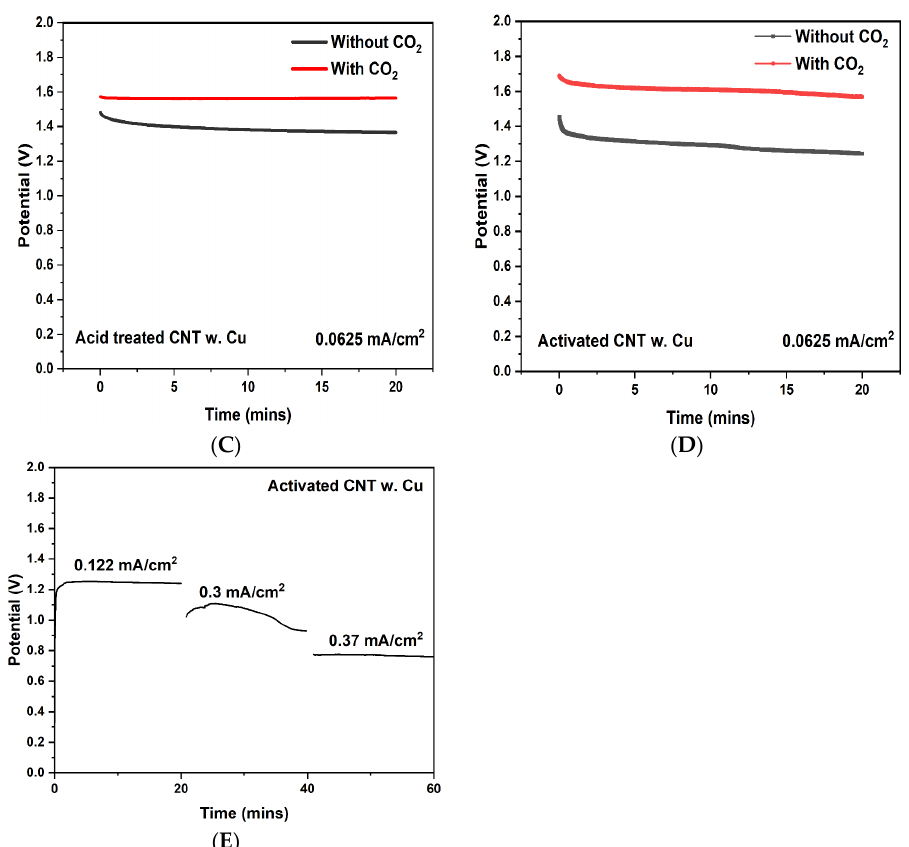
Figure 7. Discharging curve of acid-treated CNT for 20 min ( A ), activated CNT ( B ), Cu-deposited acid-treated CNT ( C ), Cu deposited activated CNT ( D ), discharging curve of Cu deposited activated CNT at different current densities ( E ).